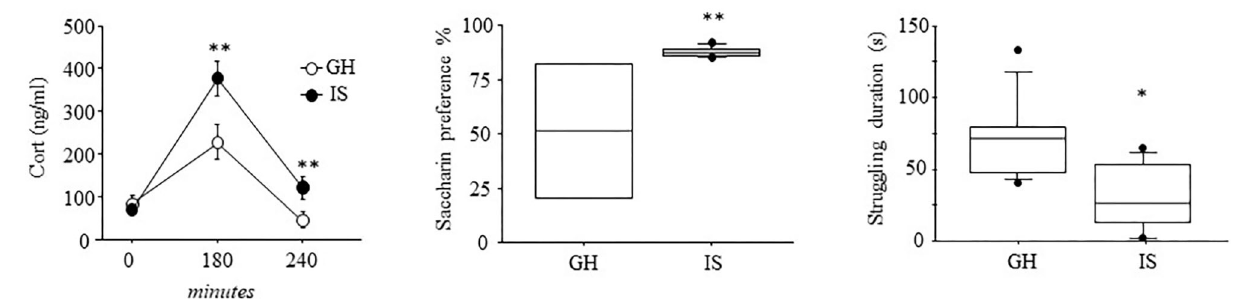
FIGURE 2 | Neuroendocrine and depressive-like behavioral profile of the MMTVNeuTg mice. Three hours of acute restraint stress resulted in higher CORT levels in the MMTVNeuTg female mice that underwent 4 months of chronic isolation stress, suggesting a stronger activation of the neuroendocrine system. The isolated mice were also characterized by elevated saccharin consumption in a saccharin preference test, as well as by reduced struggling duration, suggesting a depressive-like behavior. Data are presented graphically as means ± SEM box plots (observations outside the ranges are represented with dots outside the boxes). * p < 0.05; ** p < 0.01. Number of subjects for CORT: 8 (IS); 10 (GH); for saccharin preference: IS (7) and GH (4); for forced swim stress IS (8); GH